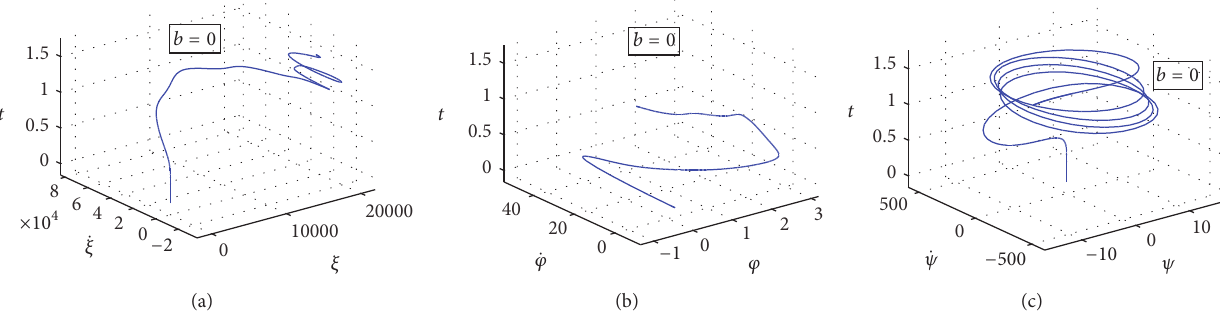
̇𝜉 via 𝑡 , (b) illustrates the variation